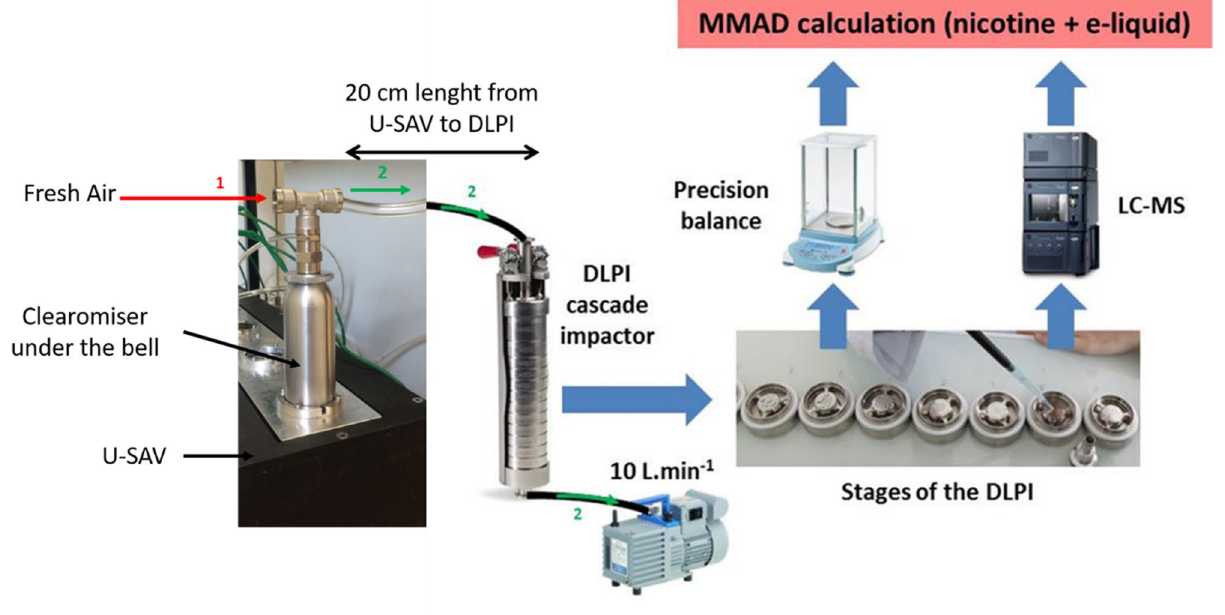
Figure 2. The experimental set-up for determining the particle-size distribution of aerosol generated by an electronic-cigarette. The emissions were generated by the U-SAV vaping machine and the particle-size distribution was measured by collecting and classifying the particles using a DLPI cascade impactor. The e-liquid collected on each stage of the cascade impactor was analyzed for nicotine concentration and density. Red arrow (1) indicates path of fresh air into the U-SAV machine. Green arrow (2) indicates path of aerosol particles through tubing from the U-SAV machine to the cascade impactor. cm centimeters, DLPI DEKATI